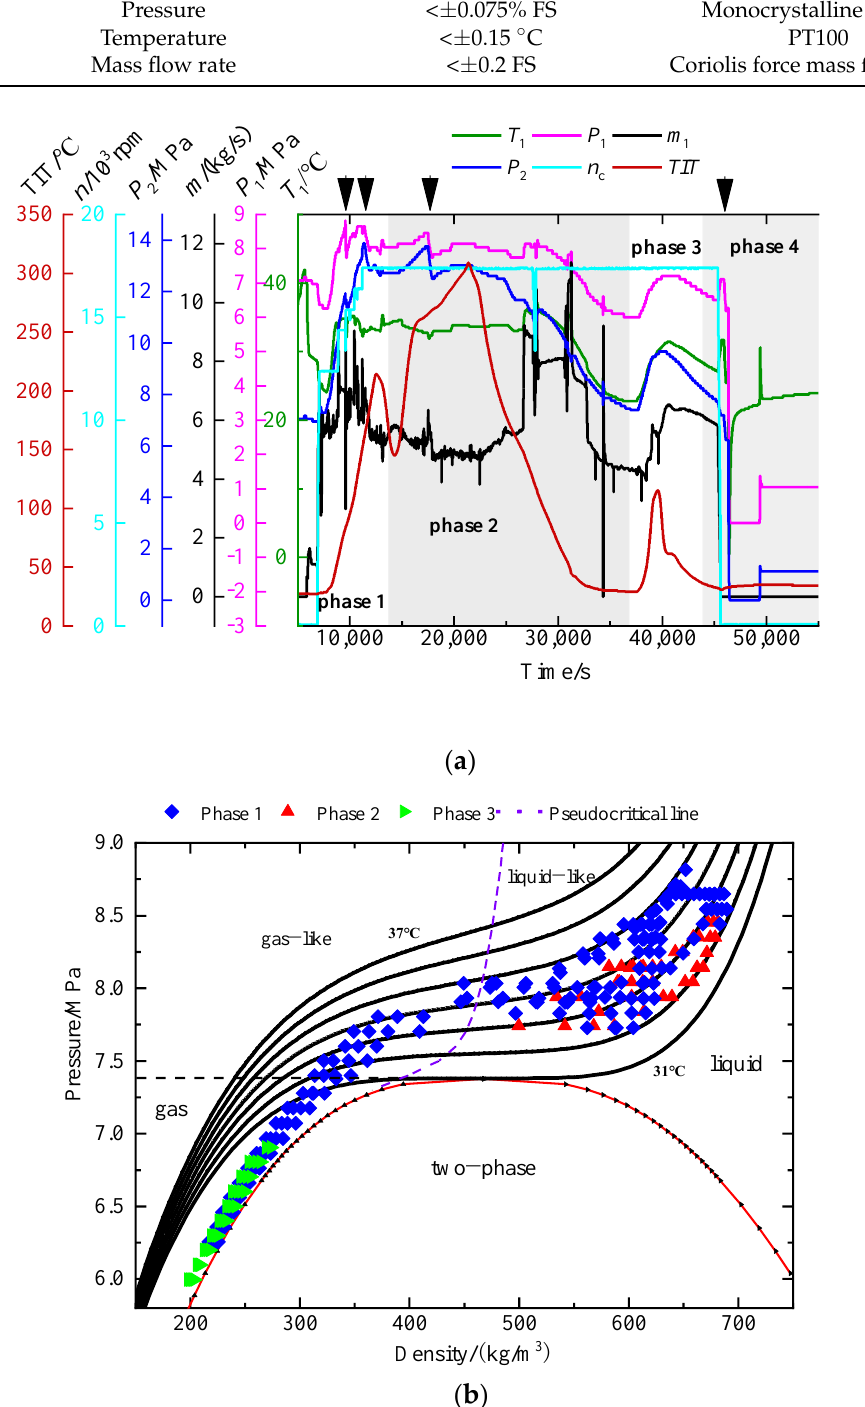
Figure 2. Test result: ( a ) test data for compressor-heater joint startup; ( b ) CO 2 pressure-density diagram at the compressor inlet.